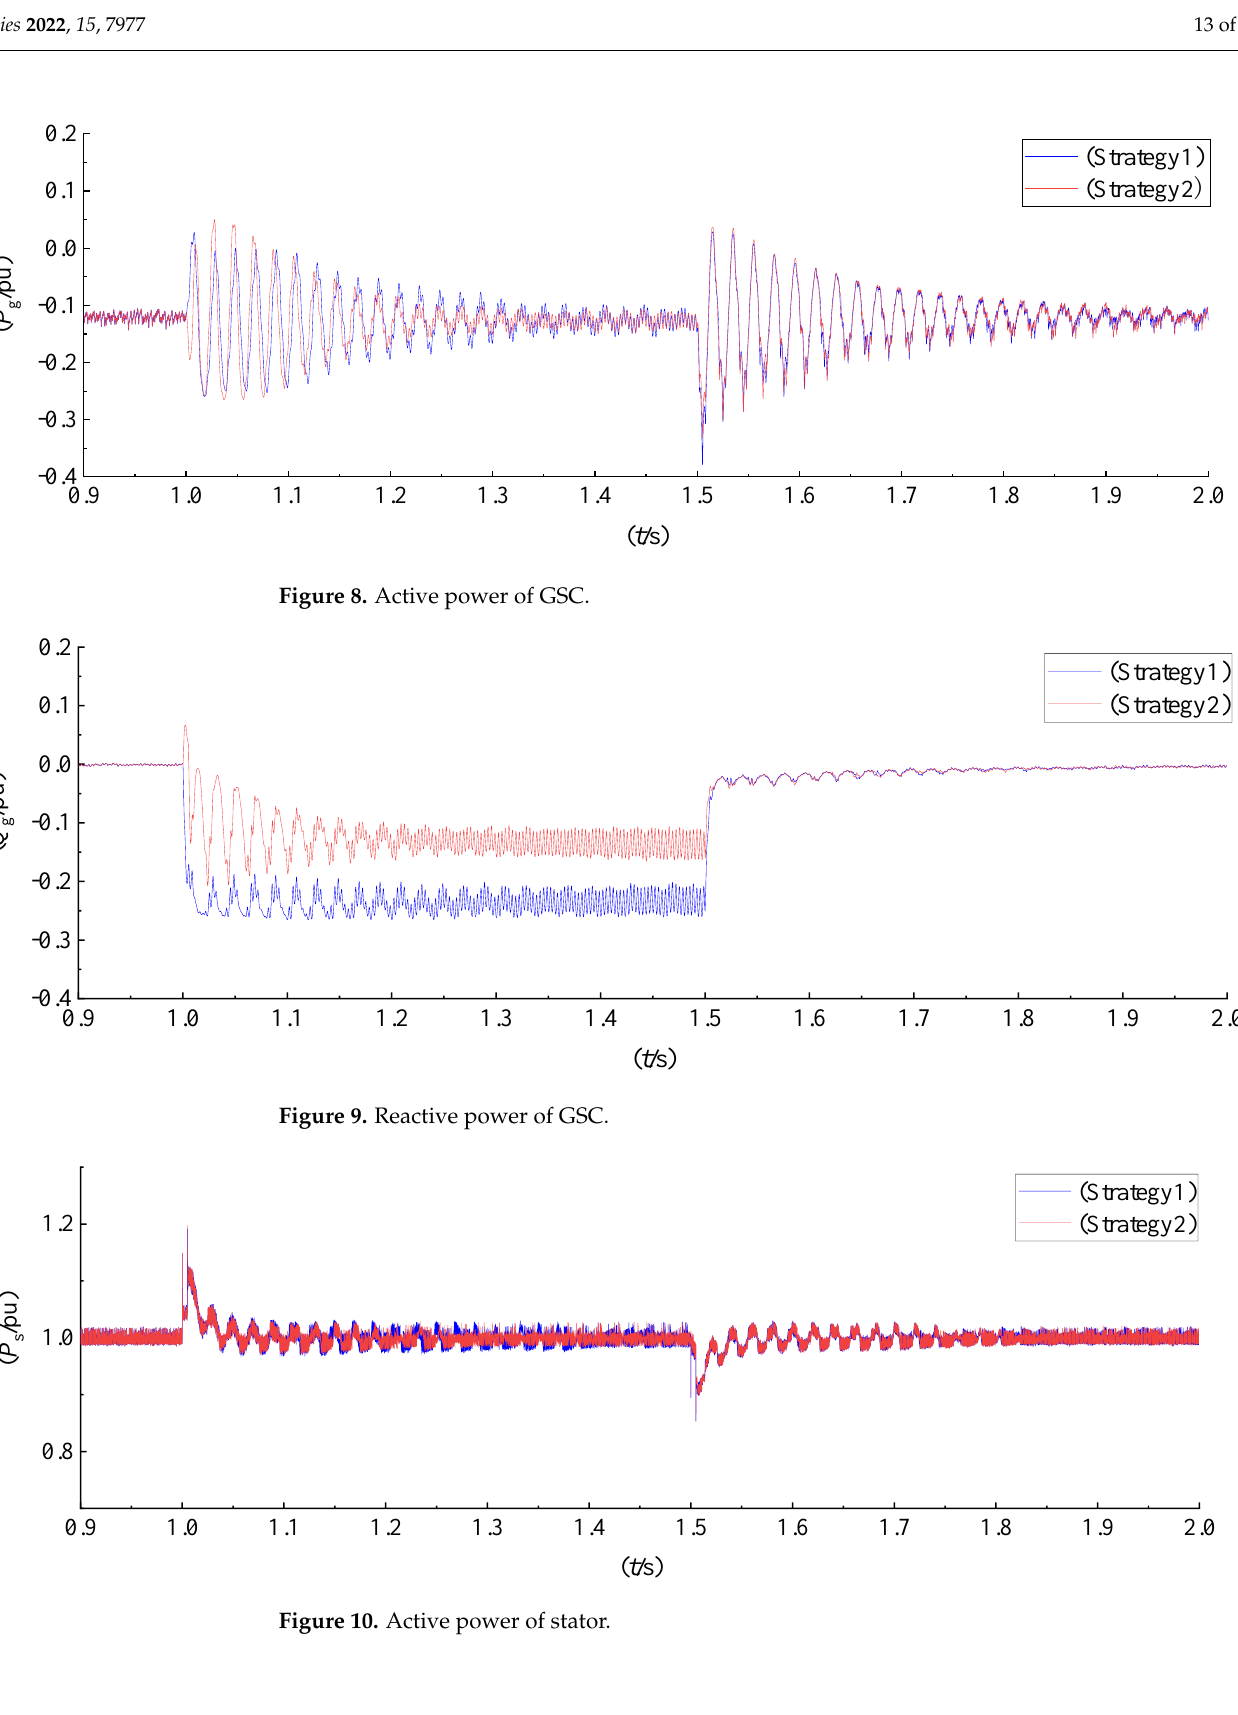
Figure 10. Active power of stator.